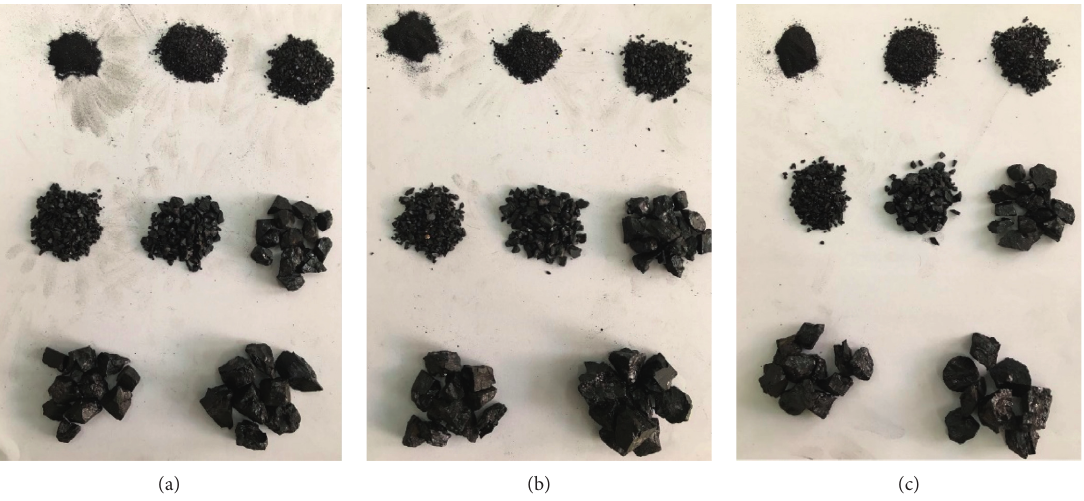
Figure 8: Sieving results of fragmentation in coal. (a) 4 MPa. (b) 7MPa. (c) 10MPa.